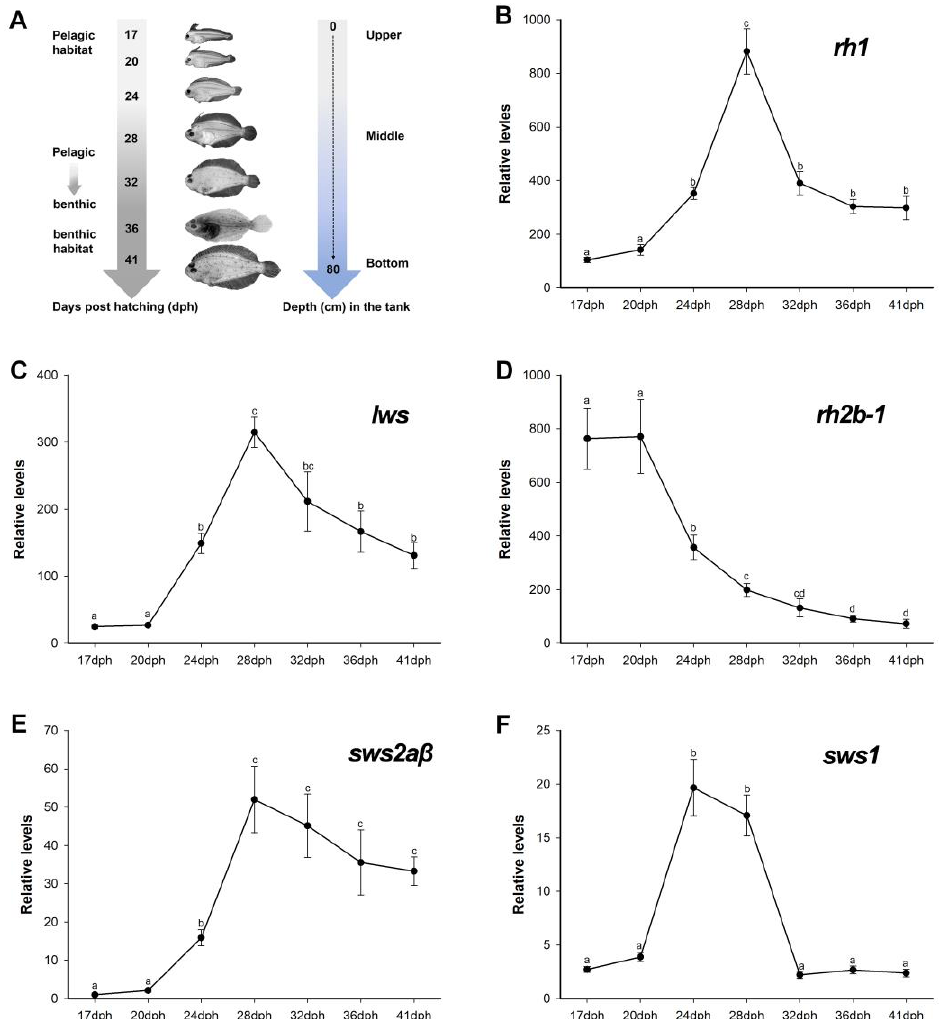
Figure 3. Expression patterns of five opsin genes during metamorphosis in flounders. ( A ) Diagram of a flounder’s migration pattern through its environment during metamorphosis. ( B ) rh 1. ( C ) lws . ( D ) rh 2 b- 1. ( E ) sws 2 a β . ( F ) sws 1. The mean ± standard error (SE) of each value ( n = 3) is shown by an error bar. The sws 2 a β level at 17 dph was used as a reference. Different letters indicate groups with significant differences ( p < 0.05) between them.